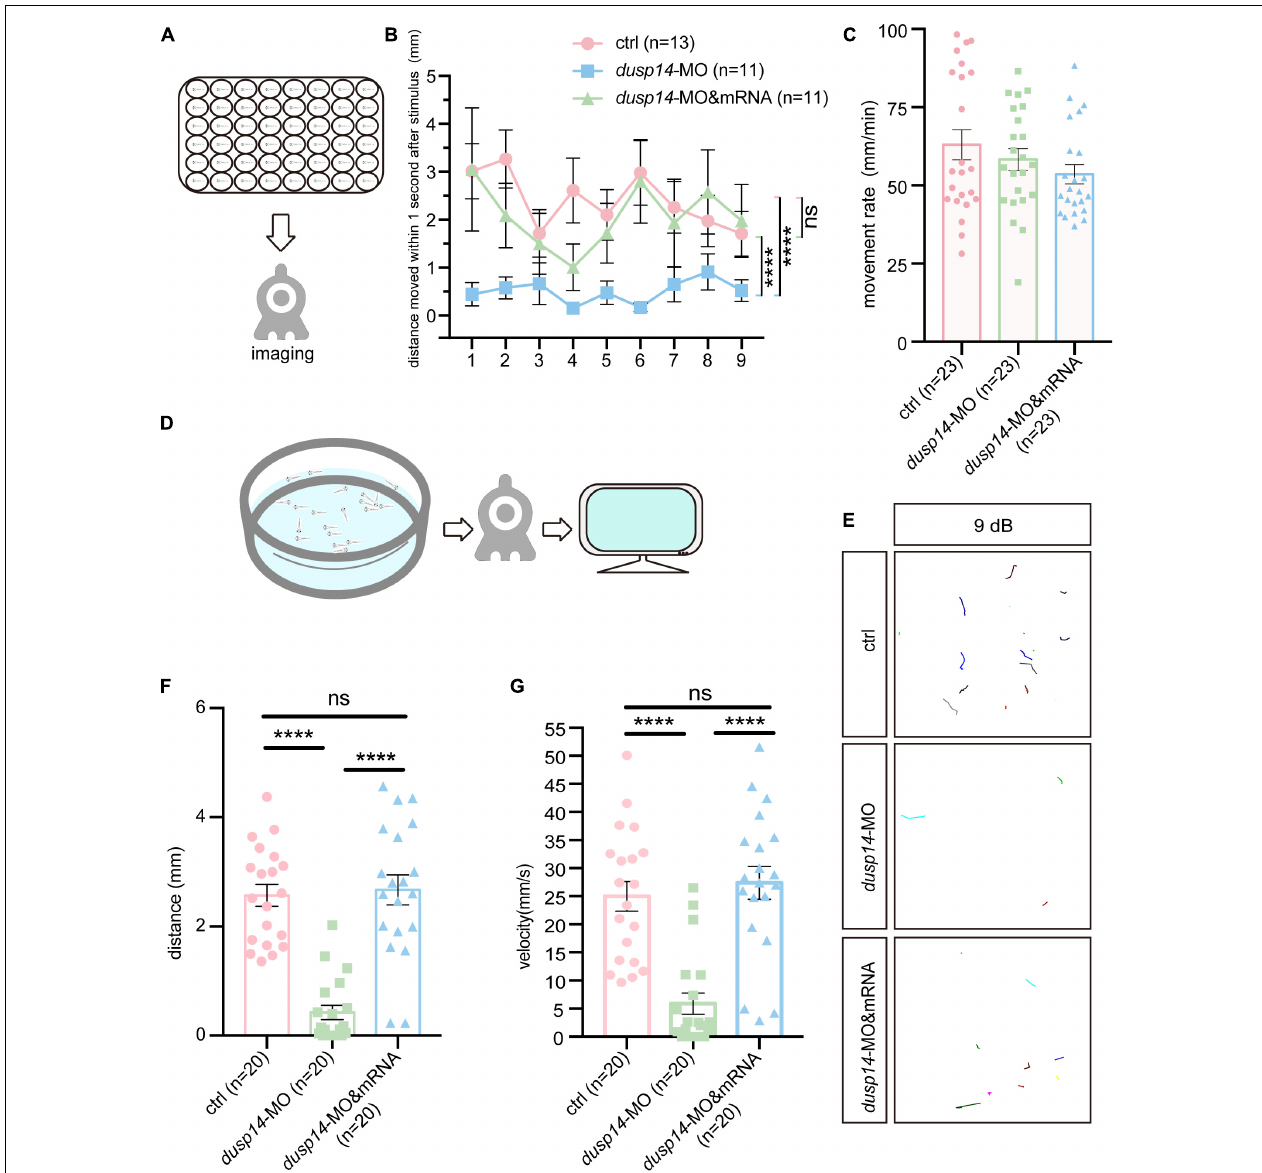
FIGURE 2 | Knockdown of dusp14 gene affects the hearing-related behavioral response in zebrafish. (A) Working diagram of acoustic or vibrational startle test after dusp14 -MO injection at 5 dpf. (B) The distance moved of zebrafish within 1 s after the percussion stimulation. (C) Statistics of the moving rate of zebrafish during the total test. (D) The schematic diagram shows the startle response testing equipment. (E) The swimming trajectory of the control, dusp14 morphants and dusp14 -mRNA and MO. (F,G) Swimming distance and peak velocity of zebrafish larvae at 5 dpf that reflected the auditory function of zebrafish larvae by examining the startle response. Values with **** above the bars are significantly different ( P < 0.0001), ns means no